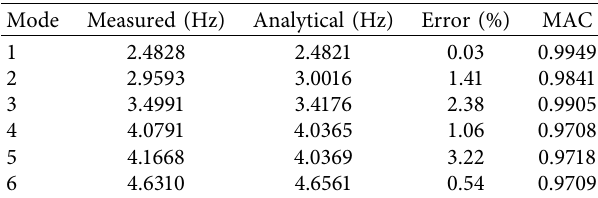
Figure 15: I-40 bridge: (a) overall layout; (b) experimental setup. Table 3: Analytical and measured natural frequencies and